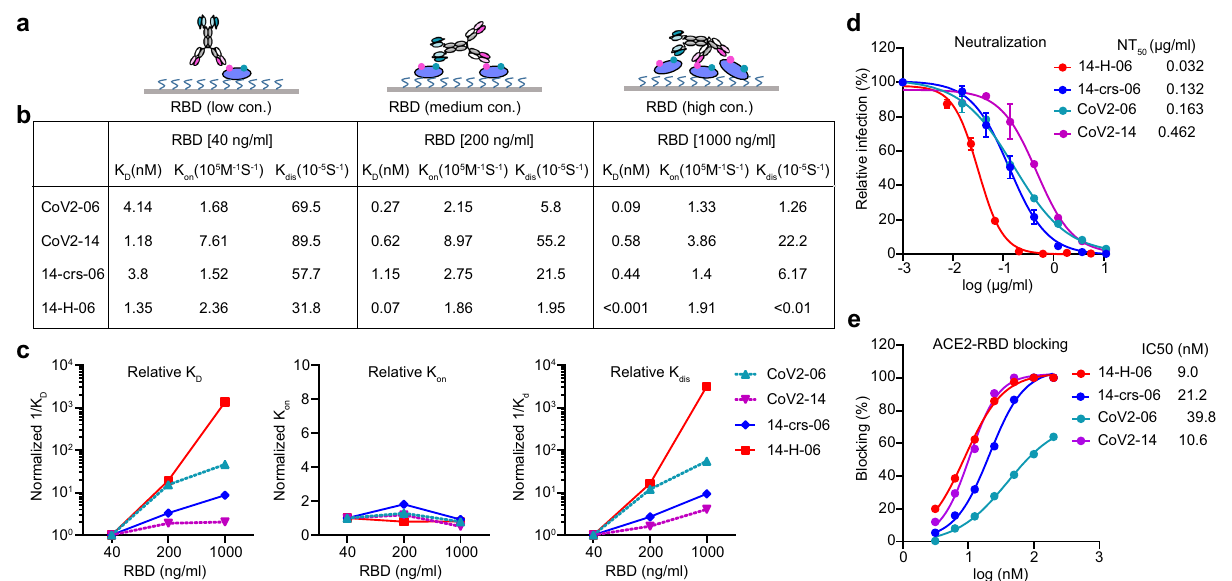
Fig. 2 | Enhanced avidity binding and virus neutralization for 14-H-06. a A diagram showing the binding models of 14-H-06 to tethered RBD antigen at the concentrations of 40ng/ml (left),200ng/ml (middle) and 1,000ng/ml (right).The avidity effects manifest as multivalent interactions between an antibody and mul- tiple RBDs. b Summary of the association (K on ), dissociation (K dis ) and avidity (K D ) of indicated antibodies at indicated concentrations RBD. c The plots of relative